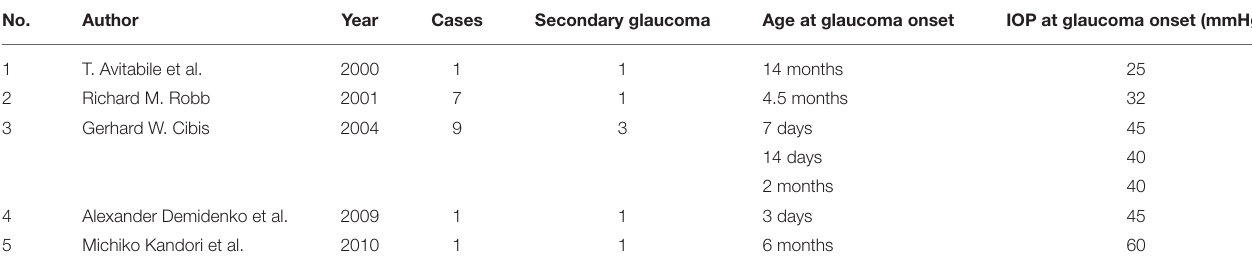
TABLE 4 | Summary of previous cases reports of the congenital fibrovascular pupillary